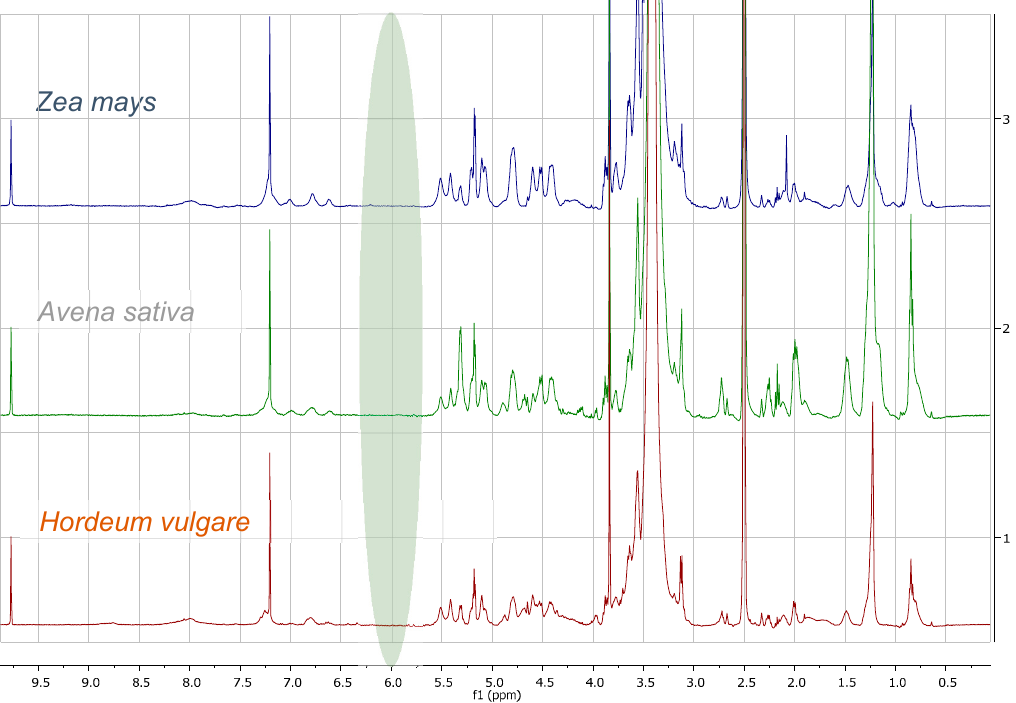
Figure A2. NMR spectra in DMSO from cereal grains without ARS.